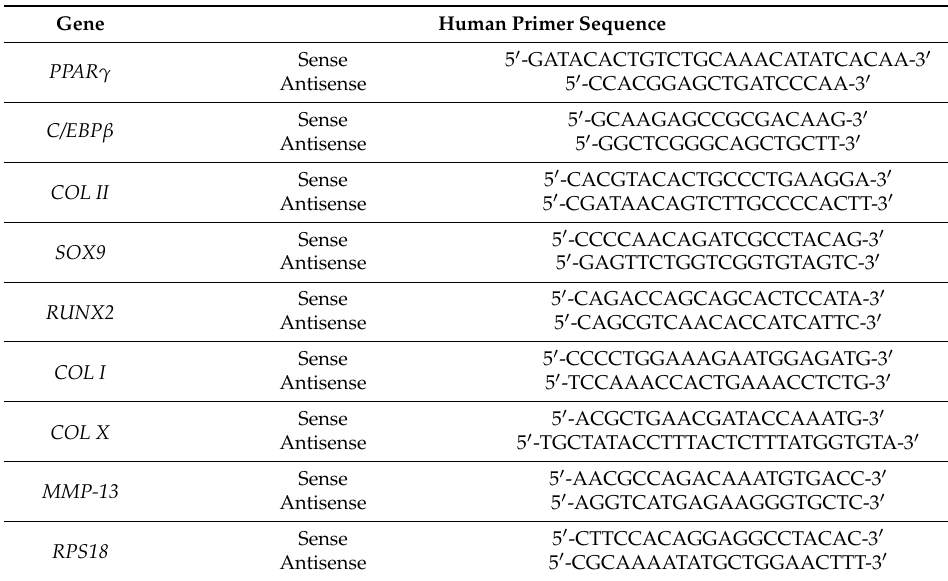
Table 1. RPS18 gene was used as a housekeeping gene to normalize gene expression in for real-time PCR analysis. Table 1. Nucleotide sequences of primer pairs for real-time